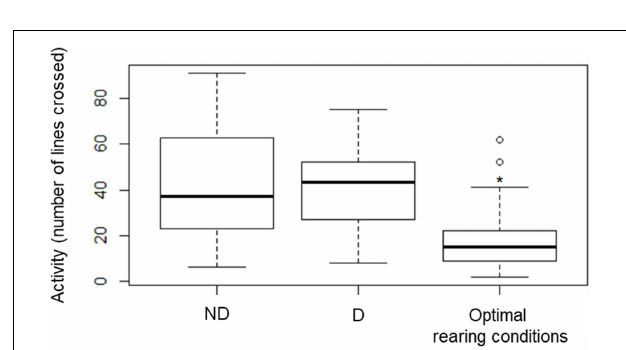
FIGURE 5 | Osmolarity (Mean ± S.D.) of food-deprived adults of Alphitobius diaperinus exposed at 10 ± 2% RH (desiccation treatment, D) or 60% RH (no desiccation, ND). Osmolarity was calculated by summing the quantities of all metabolites that were measured by GC-MS and expressed as nmoles/mg dry mass. A two-way ANOVA (using type III sum of squares) showed no effect of time ( p = 0.063) or treatment ( p = 0.669).